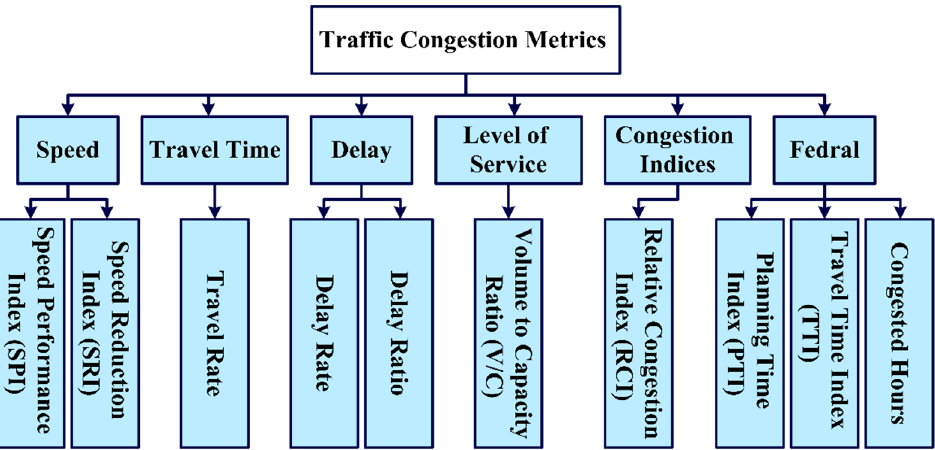
Figure 7. Traffic congestion metrics in different classes (Source: [76]).